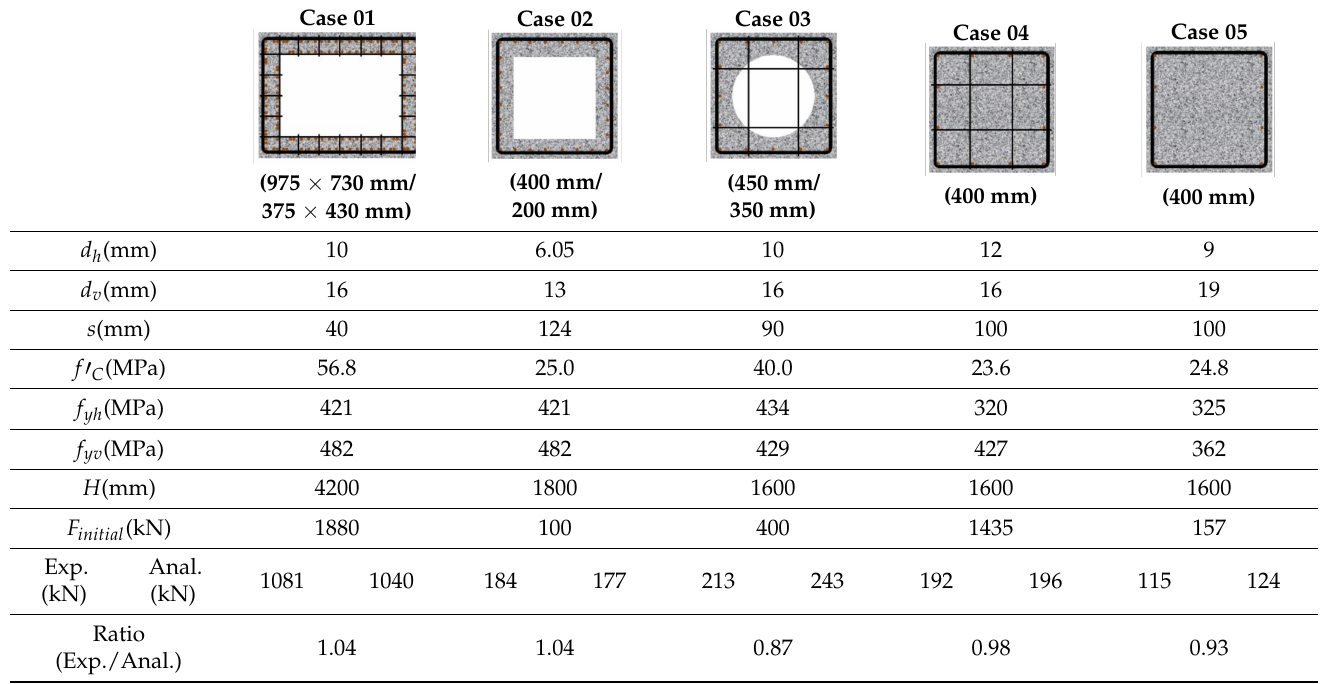
Table 1. Properties of reference solid RC